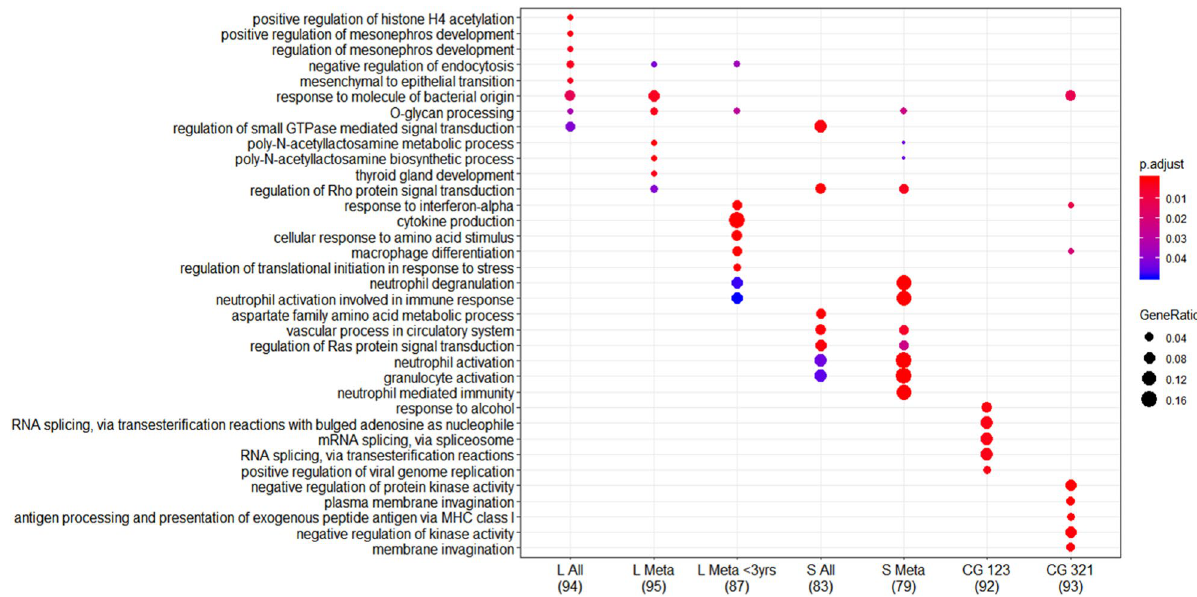
Figure 2. Visualizations of biological processes within gene ontology categories for top lists of interesting genes indicated in the different approaches described in the results. The color scale indicates significance of the overrepresentation of genes and the gene ratio signifies the number of genes in each list relative to the number of genes in ontology categories. L designate the models examined using linear regression in the ‘limma’ package (‘L All’; n = 128 pairs); all pairs with metastatic cases (‘L Meta’, n = 100 pairs); and all pairs with metastatic cases sampled within three years prior to diagnosis (‘L Meta < 3 years’; n = 36 pairs), whereas S designate the spline regressions examined for all pairs and all pairs with metastatic cases using ‘limma’. For the significant curve groups identified, CG 123 and CG 321, the genes in the two significant curve groups were presented. Numbers in brackets signify the numbers of genes in each list with identified Entrez IDs that were included into the overrepresentation analyses. Graphical representation of ontologies were generated using the R package clusterProfiler 29